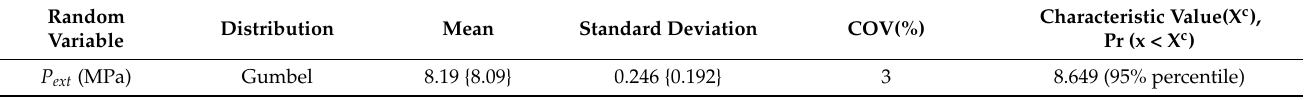
Table 3. Probabilistic model for external